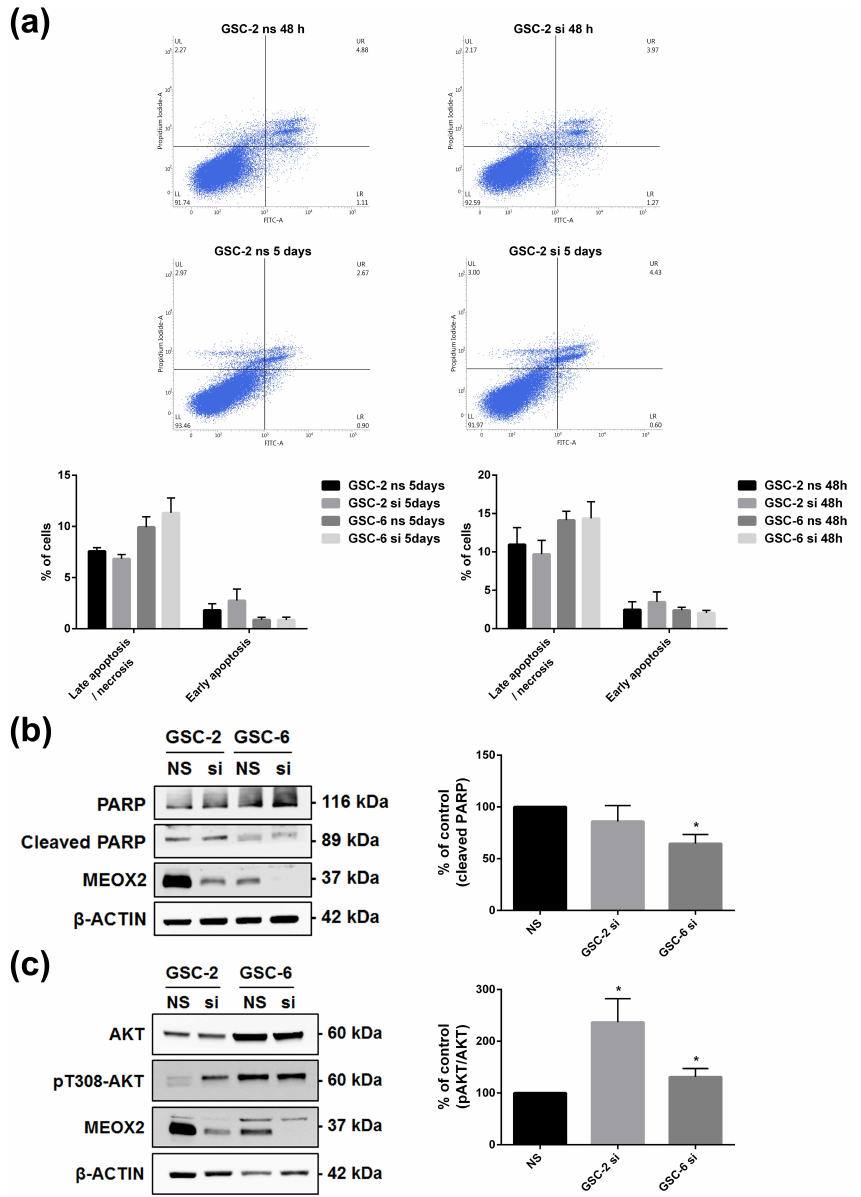
Figure 4. Cell survival regulation by MEOX2 through PI3K/AKT pathway. ( a ) Representative plots of FACS analysis of Annexin V/PI after inhibition of MEOX2 (siRNA1) for 48 h or 5 days in GSC-2; ( b ) Representative WB and histograms of cleaved-PARP decrease after inhibition of MEOX2 (siRNA1) for 48 h ( n = 4, * p < 0.05, Mann–Whitney test); ( c ) Representative WB and histograms of the activation of AKT pathway after inhibition of MEOX2 (siRNA1) for 48 h in GSC-2 and GSC-6 ( n = 4, * p < 0.05, Mann–Whitney